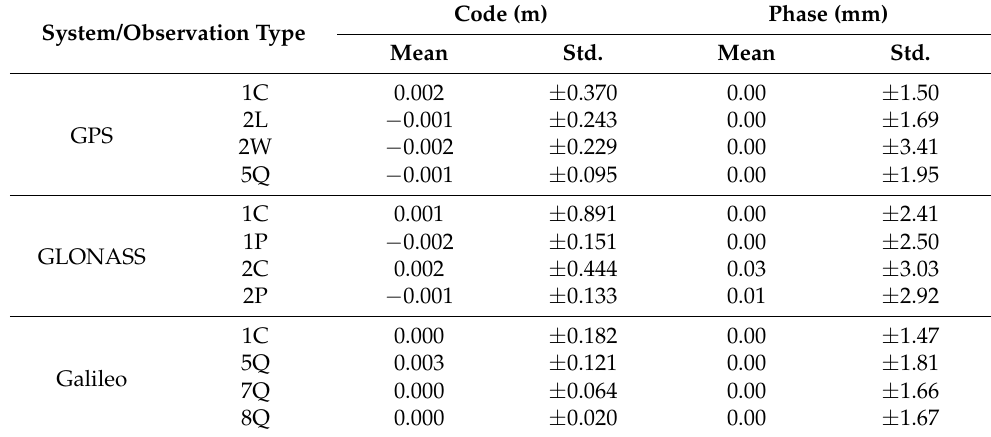
Table 2. Statistics for ZB DD code and carrier phase noise for the weekly solution.